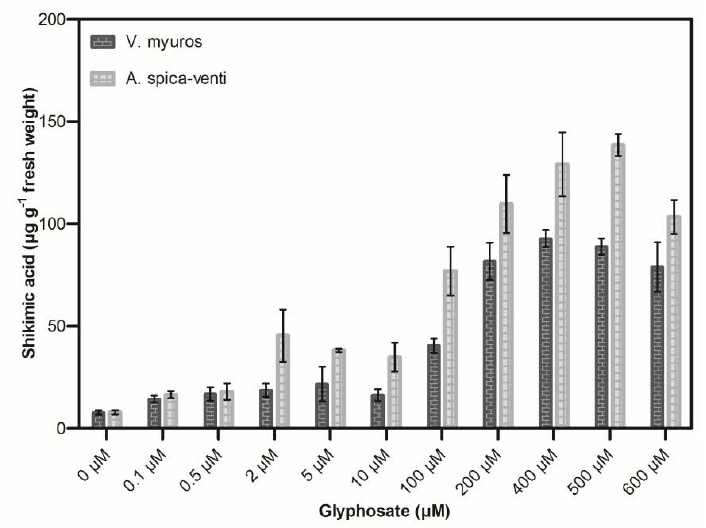
Figure 3. Accumulation of shikimic acid in leaves of Vulpia myuros and Apera spica-venti following treatment with glyphosate (210 and 410 g ae ha −1 ). Vertical bars are presenting standard errors of the means.